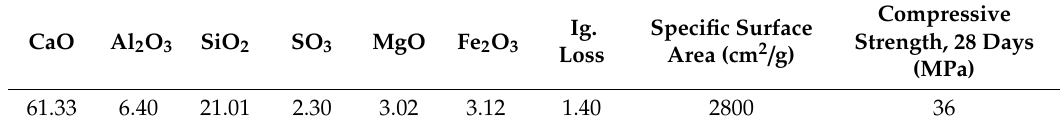
Table 1. Chemical composition and physical properties of the